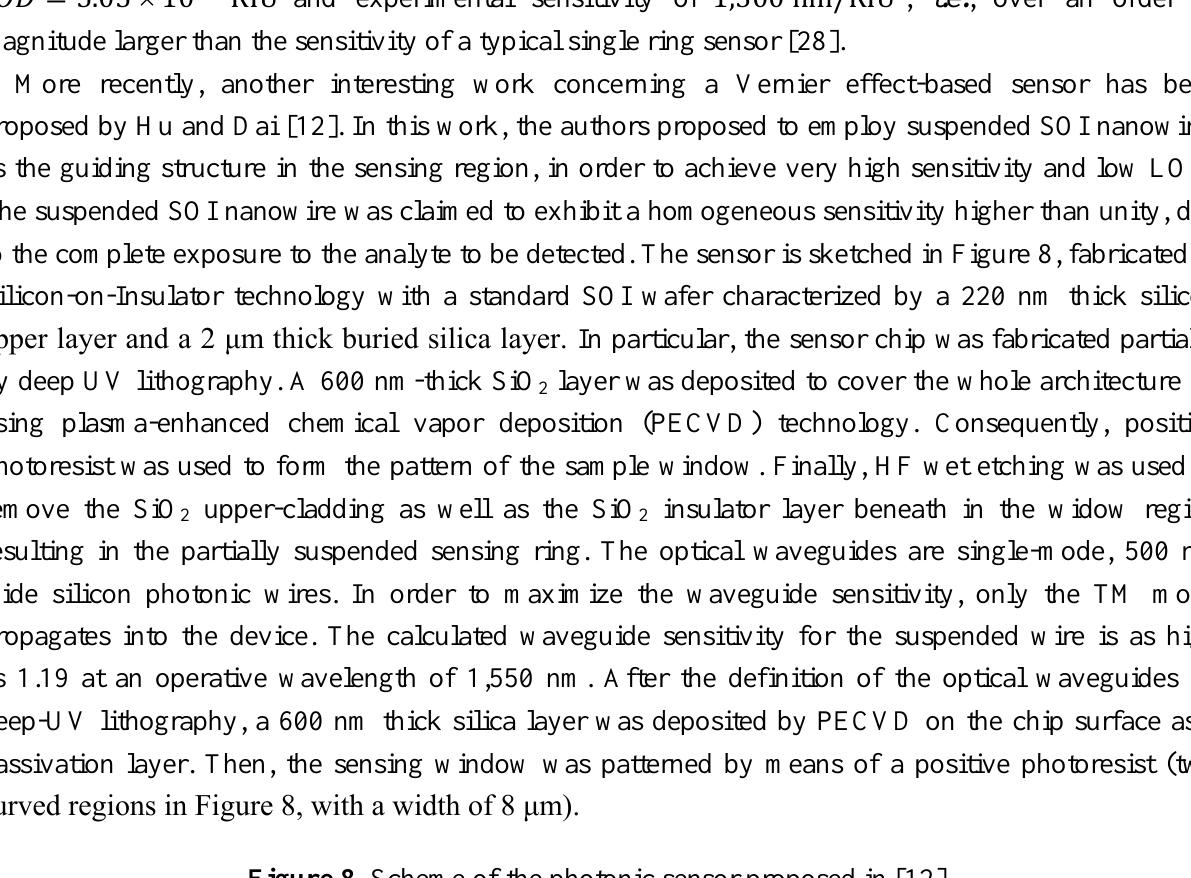
Figure 8. Scheme of the photonic sensor proposed in